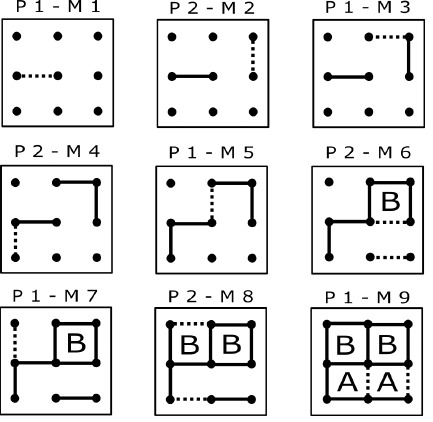
Figure 1. Dots and Boxes game between two players.